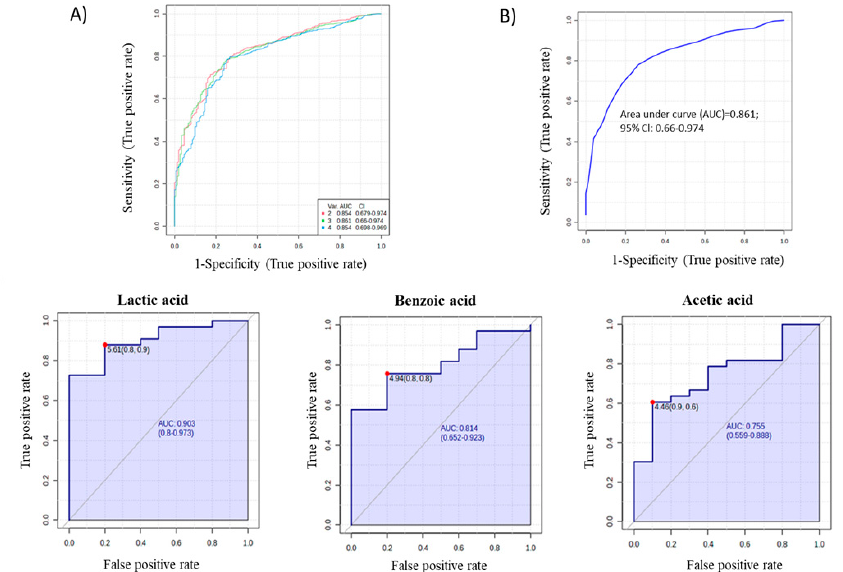
Figure 7. ROC curves and AUC values for all statistically significant metabolites ( A ), multivariate analysis of the ROC curve for the 3 metabolites ( B ), and individual ROC curves for the 3 metabolites ( C ), which can distinguish WFS patients from both T1DM patients and healthy subjects.